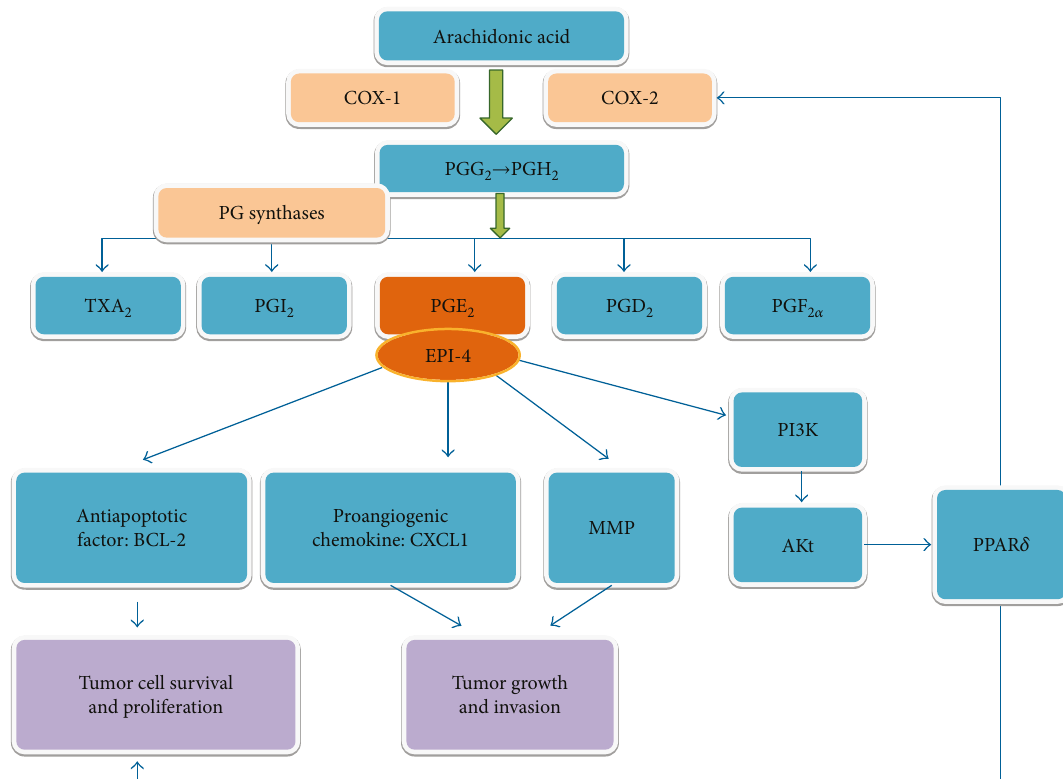
Figure 2: The role of COX-2/PGE pathway in colitis-associated CRC. The COX enzymes catalyze the biosynthesis of PGG and PGH from 2 2 2 arachidonic acid. PGH is subsequently metabolized to TXA , PGI , PGE , PGD , and PGF by PG synthases. COX-2-derived PGE acts via 2 2 2 2 2 2 α 2 speci fi c receptor EP1-4 and plays an important role in tumor development and progression through inducing expression of antiapoptotic proteins (such as BCL-2), proangiogenic chemokines (such as CXCL1), and MMP. In addition, PGE mediates the activation of PPAR δ 2 through PI3K/Akt signaling. PPAR δ contributes to tumorigenesis by ensuring tumor cell survival and proliferation. Activation of PPAR δ can further enhance the production of COX-2-derived PGE 2